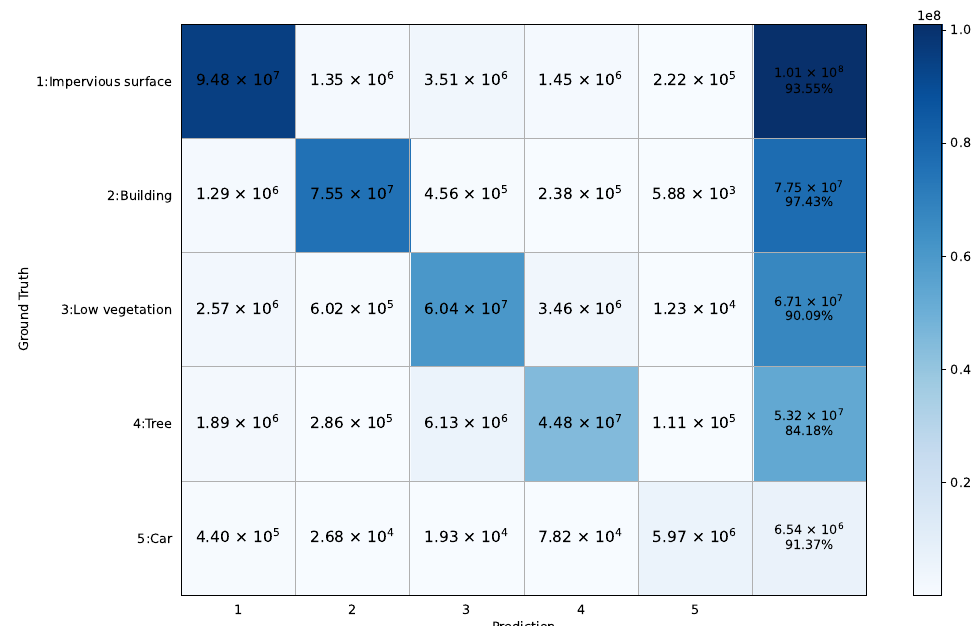
Figure 6. The confusion matrix for the Potsdam dataset using GMAUResNeXt_v2. The number in the confusion matrix refers to the number of pixels of ground truth predicted for a specific class. The rightmost column indicates the overall accuracy and the total number of pixels for a certain ground object.